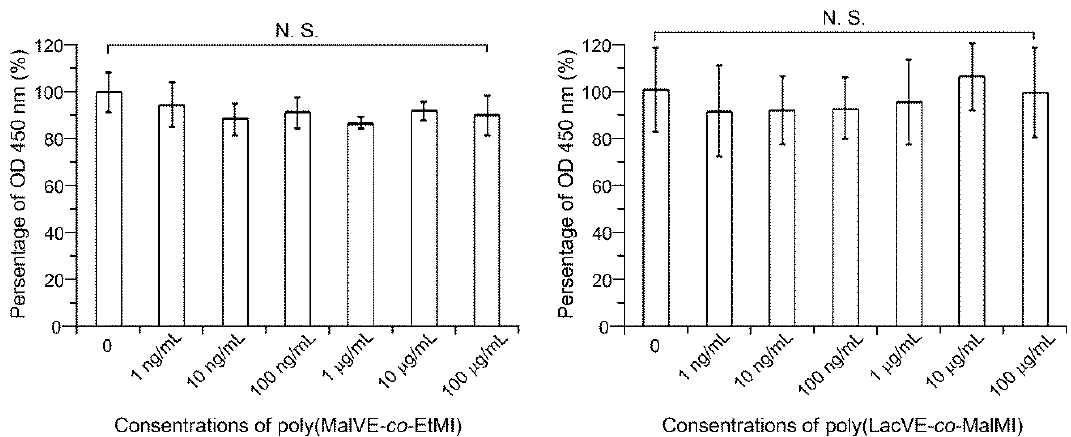
Figure 9. Cytotoxicity studies for the obtained glycopolymers. The mouse mesenchymal stem cell line (D1 cell) was treated with/without poly(MalVE- co -EtMI) or poly(LacVE- co -MalMI) for four days. The data were normalized to the control group without polymers. The results are presented as percentages (control group: 100%). Data represent the mean with standard deviation ( n = 5 per group). N.S., not significant.